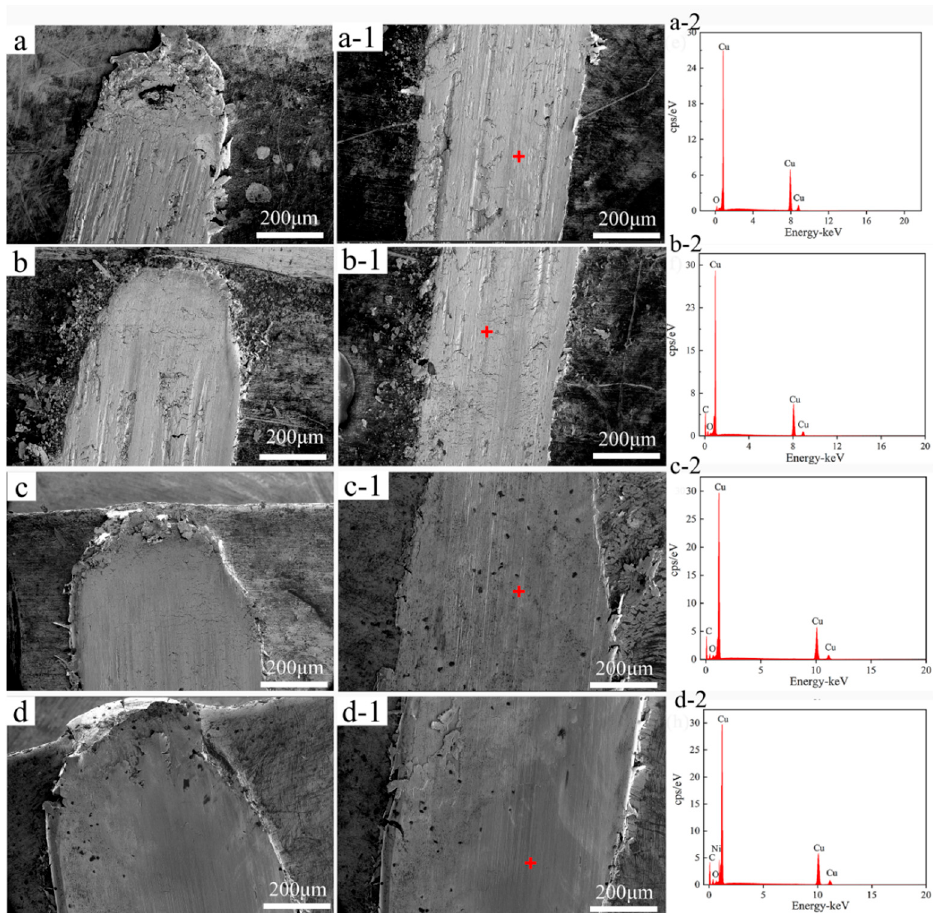
Figure 9. SEM micrographs and corresponding EDS of wear trajectories on the surface parallel to drawing direction of ( a , a-1 , a-2 ) Pure Cu, ( b , b-1 , b-2 ) B-MWCNTs/Cu composite, ( c , c-1 , c-2 ) Cu@MWCNTs/Cu composite, ( d , d-1 , d-2 ) Ni@MWCNTs/Cu